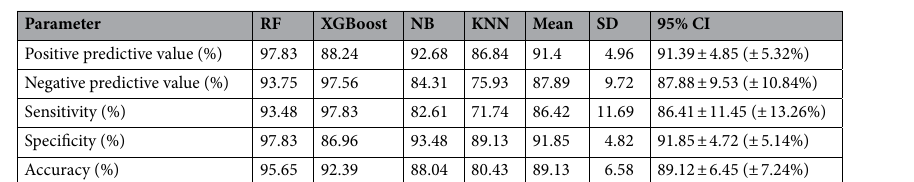
Table 3. Model performance.